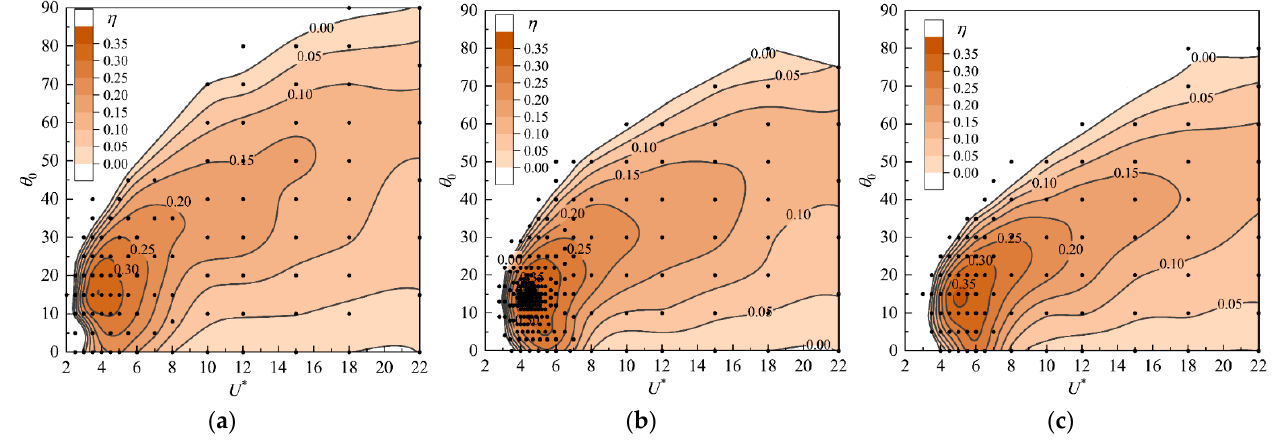
Figure 11. Contour maps of efficiency in the two-dimensional space composed of the reduced speed and pitching amplitude. ( a ) H 0 = 1.0. ( b ) H 0 = 1.4. ( c ) H 0 =